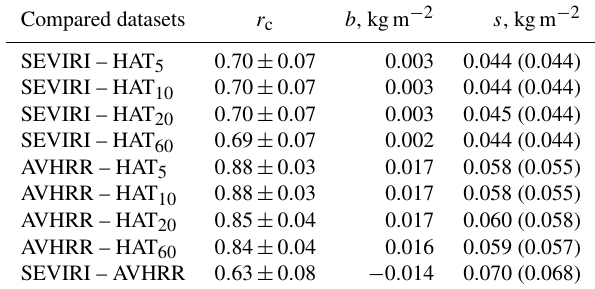
Table 2. The same as Table 1 but for the CD season. Total number of data points N is 53; the mean LWP values for HATPRO datasets are in the range of 0.022–0.023kgm − 2